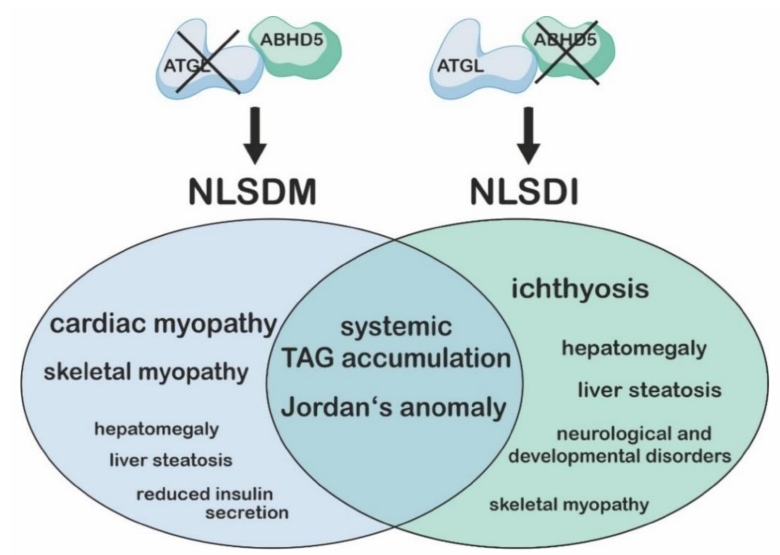
Figure 2. Similarities and differences in the clinical manifestations of Neutral Lipid Storage Disease with Myopathy (NLSDM) vs. Neutral Lipid Storage Disease with Ichthyosis (NLSDI). Mutations in the gene encoding adipose triglyceride lipase (ATGL) cause NLSDM, while mutations in the gene coding for α / β hydrolase domain containing protein 5 (ABHD5) are associated with NLSDI. Both syndromes are characterized by systemic triacylglycerol accumulation and Jordans’ anomaly, which describes an accumulation of lipid-containing vacuoles in leukocytes. While NLSDM is associated with severe forms of cardiac myopathy, patients with NLSDI always suffer from ichthyosis. In addition, NLSDM patients often show clinical manifestations of skeletal myopathy and less commonly hepatomegaly, liver steatosis, or reduced insulin secretion rates. In contrast, NLSDI patients often suffer from liver steatosis, hepatomegaly, and neurological disorders and rarely from skeletal